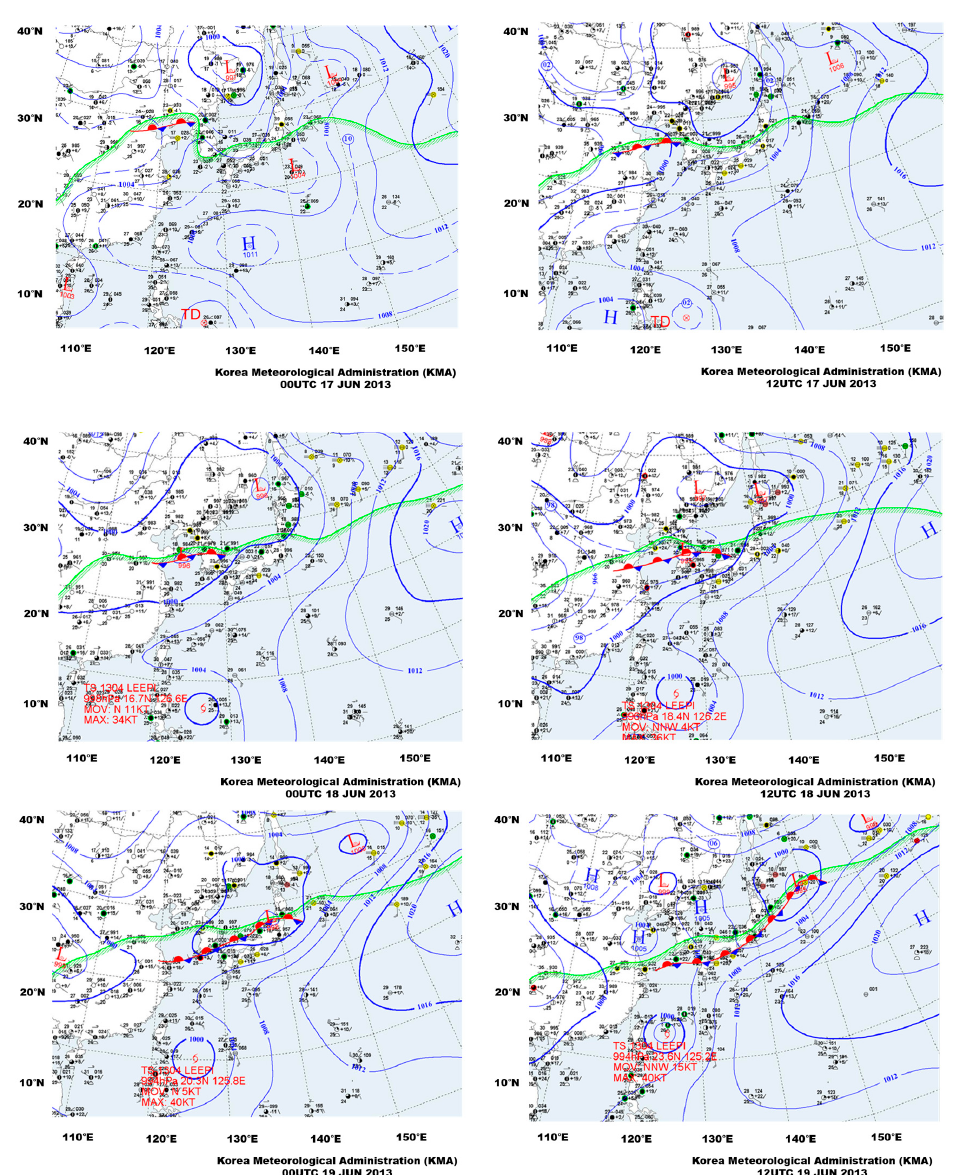
Figure 3. Surface weather maps show Jangma front movement. The green line and the hatched zone indicate the area where the dew point temperature is 20 °C or higher.